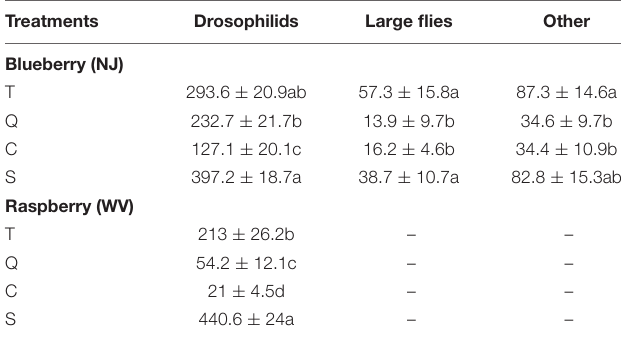
TABLE 4 | Mean ( ± SE) capture (per trap) of non-target: drosophilids, large flies, and other arthropods over the course of trapping (June 13 to September 26) in blueberry New Jersey (NJ) and raspberry West Virginia (WV) in